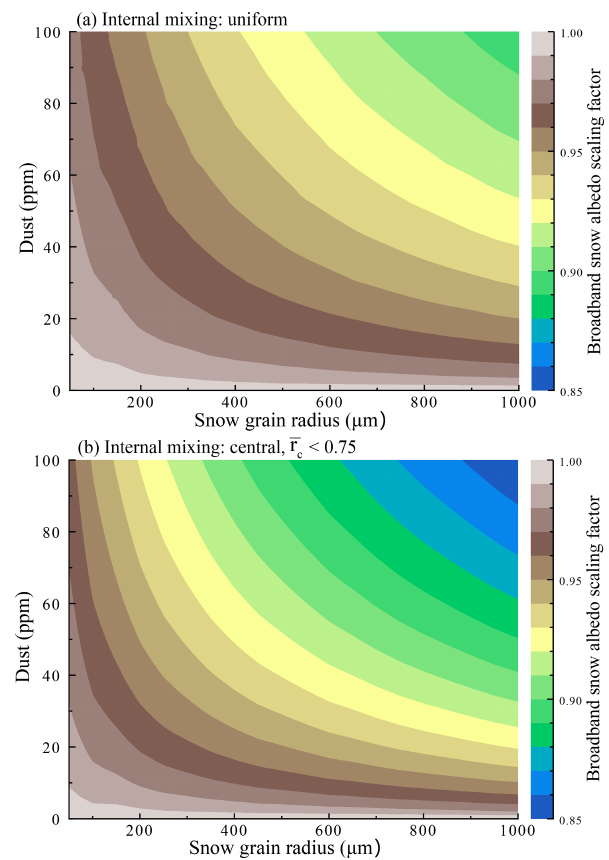
Figure 8. Variations in the broadband snow albedo scaling factor ( E α , ratio of α integrated for IDM to EDM) due to different integrated dust mass concentrations and snow grain radii for (a) internal mix- ing (uniform) and (b) internal mixing (central, r c < 0 . 75).